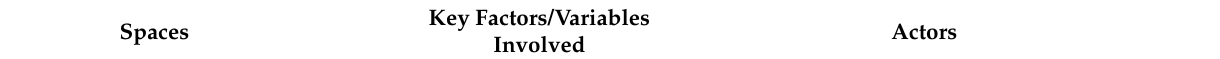
Table 1. The three layers of the analytic